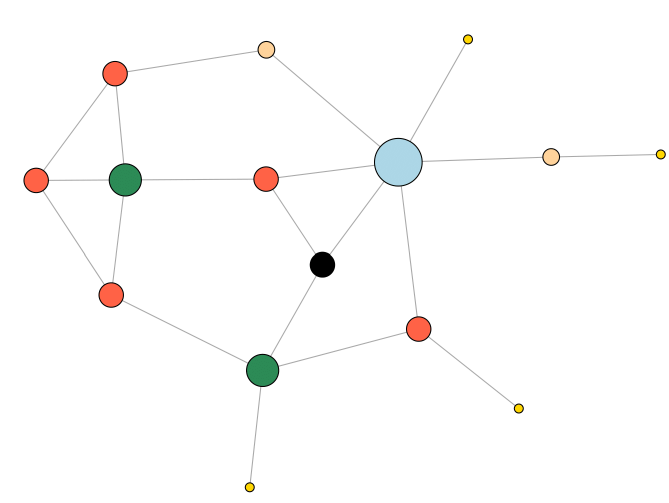
Figure 2. The illustration of the PageRank ranking algorithm.